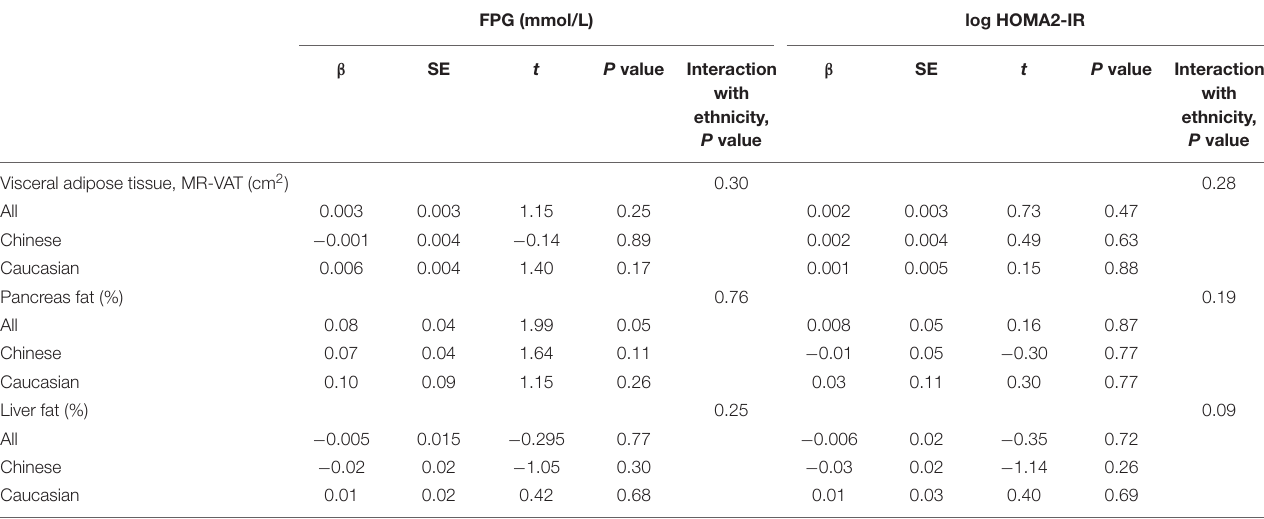
TABLE 2 | Relationships between fasting plasma glucose, and insulin resistance (log HOMA2-IR) with visceral adipose tissue, pancreas, and liver fat in the MR cohort. FPG (mmol/L) log HOMA2-IR